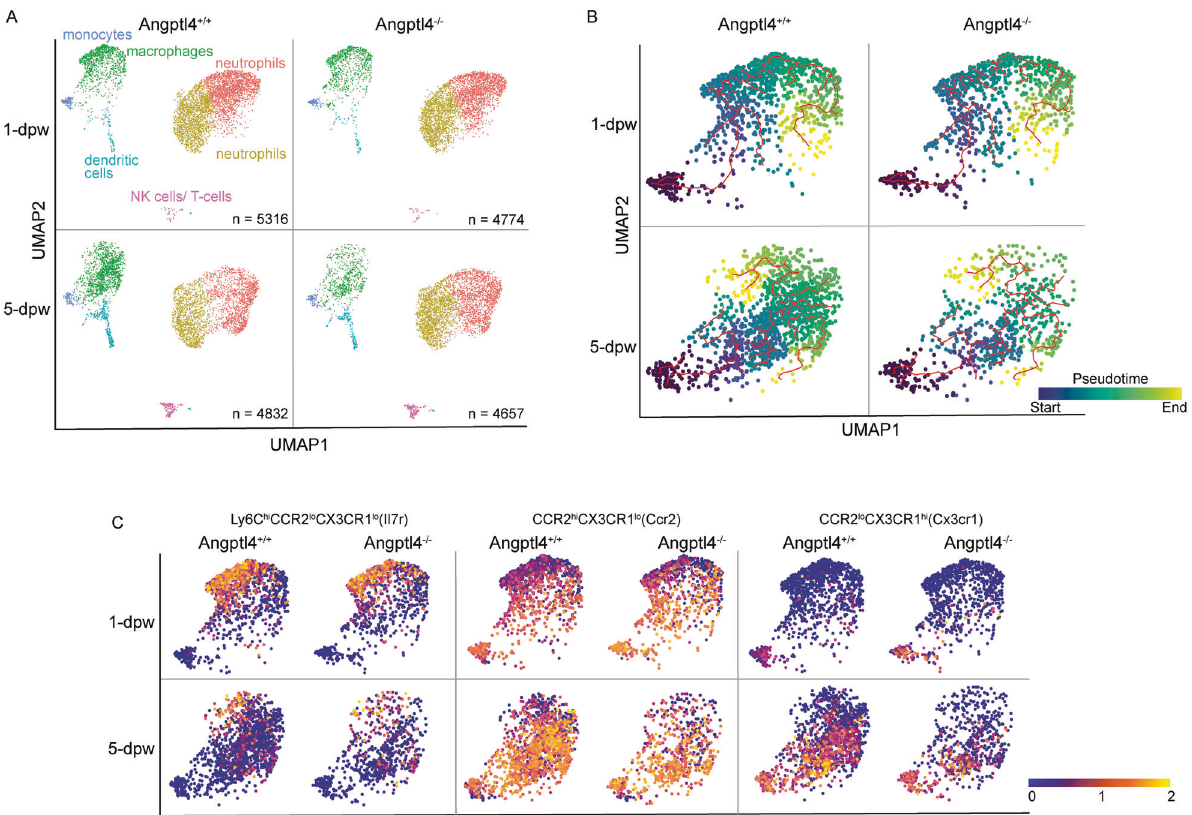
Fig. 1 Single-cell immune landscape during mouse skin excisional wound healing. A Individual UMAP dimensionality reduction plots of sequenced CD45 + immune cells from Angptl4 + / + and Angptl4 − / − wounds at 1 and 5 days post-wounding (dpw). B UMAP dimension reduction plots showing cells from individual scRNA-seq samples ordered by pseudotime (color scale). Monocytes were marked as the start of pseudotime. Calculated cell trajectories are shown as red lines. C The distribution of cells expressing Il7r, Ccr2 and Cx3cr1 during the recovery of Angptl4 + / + and Angptl4 − / −